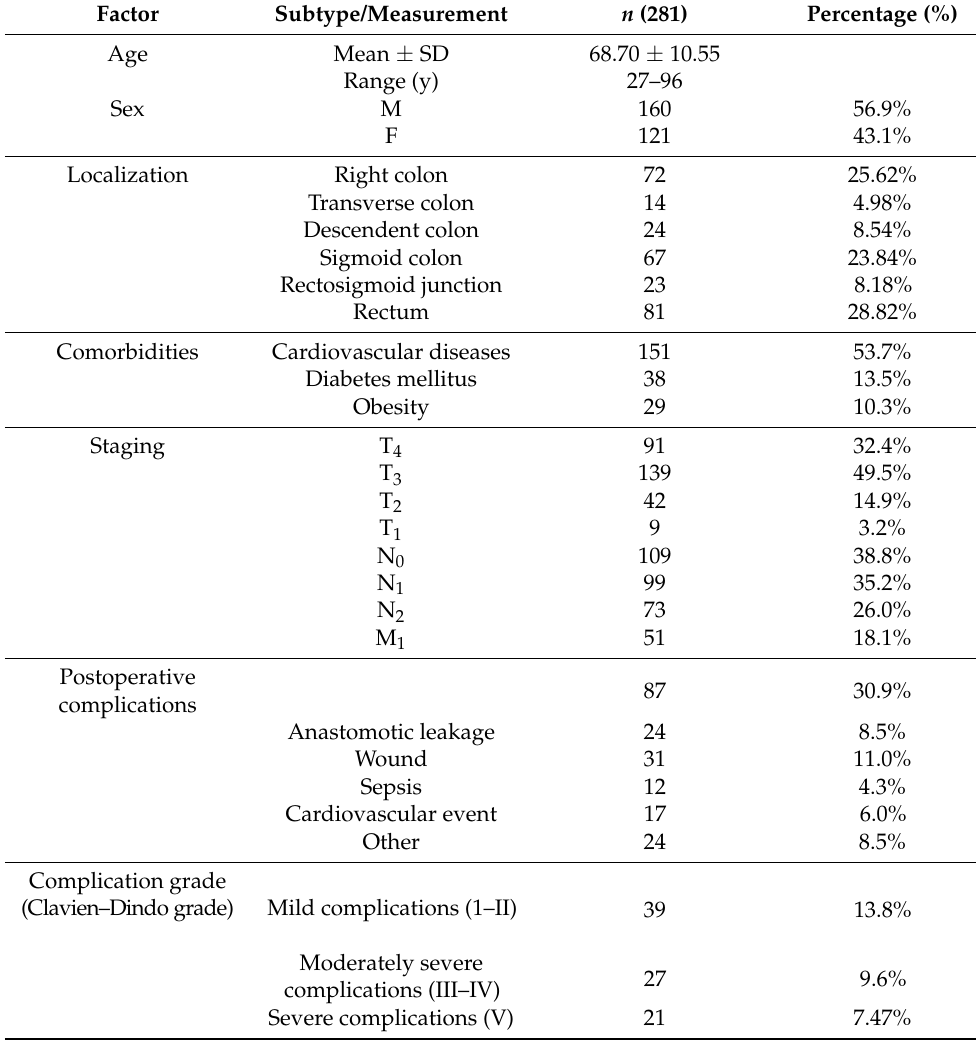
Table 1. Clinical and demographic characteristics of the enrolled